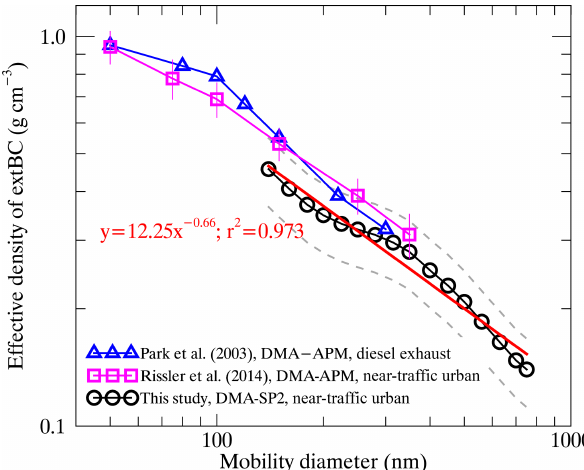
Figure 4. The effective density ( ρ eff ) of the extBC particles as a function of the mobility diameter ( d mob ) (black circles). The red line represents the power-law fitting of ρ eff versus d mob . The varia- tions in ρ eff with d mob measured for the soot agglomerates from diesel exhaust (Park et al., 2003) and near-traffic urban environ- ments (Rissler et al., 2014) are also presented as blue triangles and red squares, respectively. The dashed lines represent the uncertain- ties in the determined ρ eff